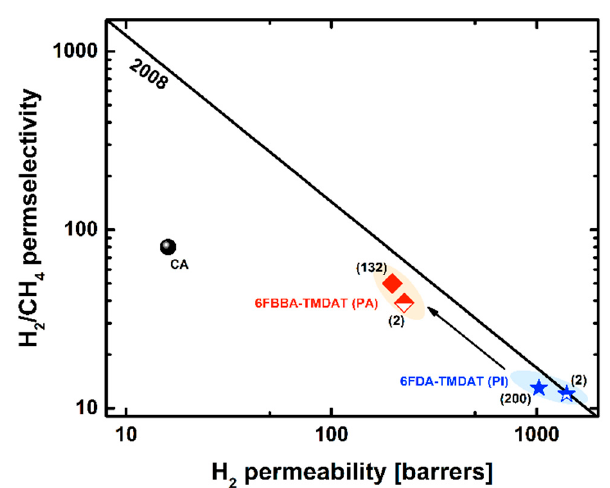
Figure 10. Location of 6FBBA-TMDAT polyamide on pure-gas H 2 -CH 4 upper bound (2008) plot [65]. Cellulose acetate (CA) [64] and 6FDA-TMDAT [45] are shown for comparison. Aging (closed symbols) was recorded for 132 and 200 days for 6FBBA-TMDAT (polyamide) and 6FDA-TMDAT (polyimide), respectively (as also indicated in the plot).